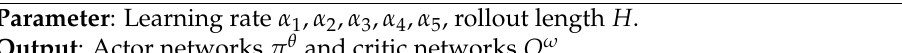
Algorithm 1 Centralized